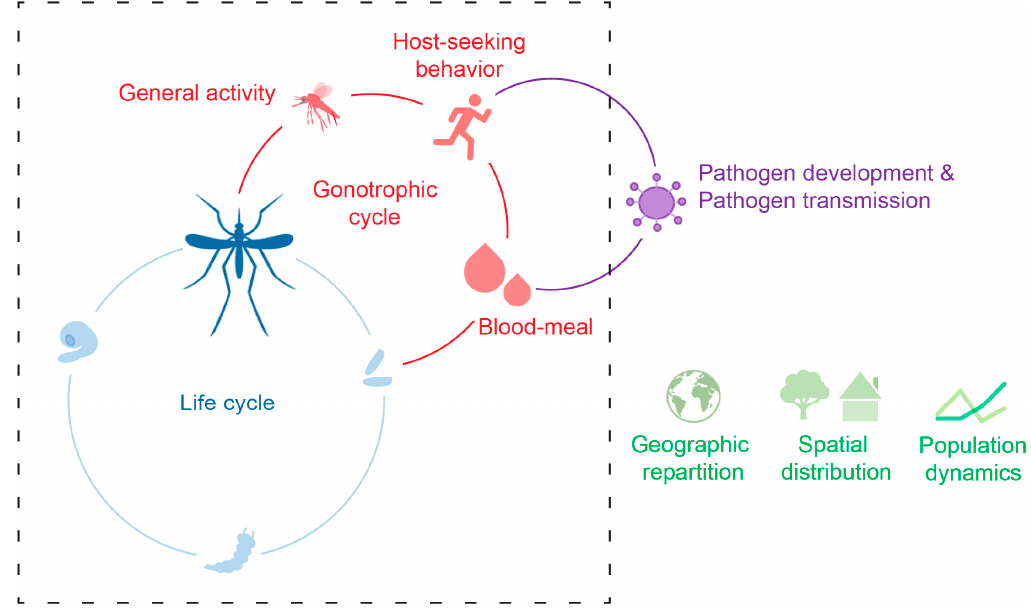
Figure 1. The temperature of the environment ( T a ) affects the mosquito development (blue), its activity including host-seeking and blood-meal intake (red), as well as pathogen development and transmission (purple). Consequently, T a affects species geographic repartition, spatial distribution, and population dynamics (green). The dashed square represents the cycles related to mosquito biology.